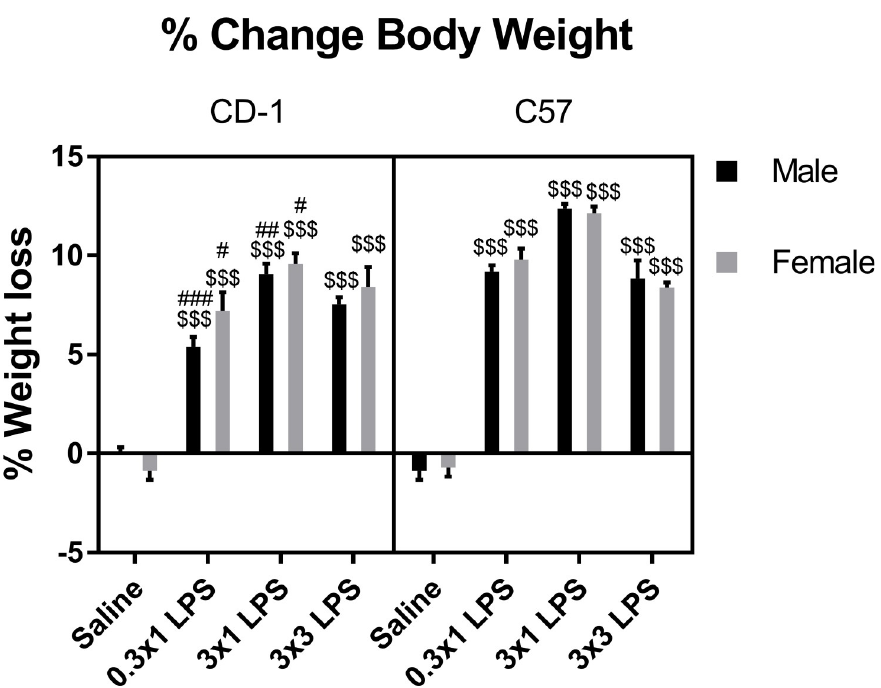
same treatment group and sex.